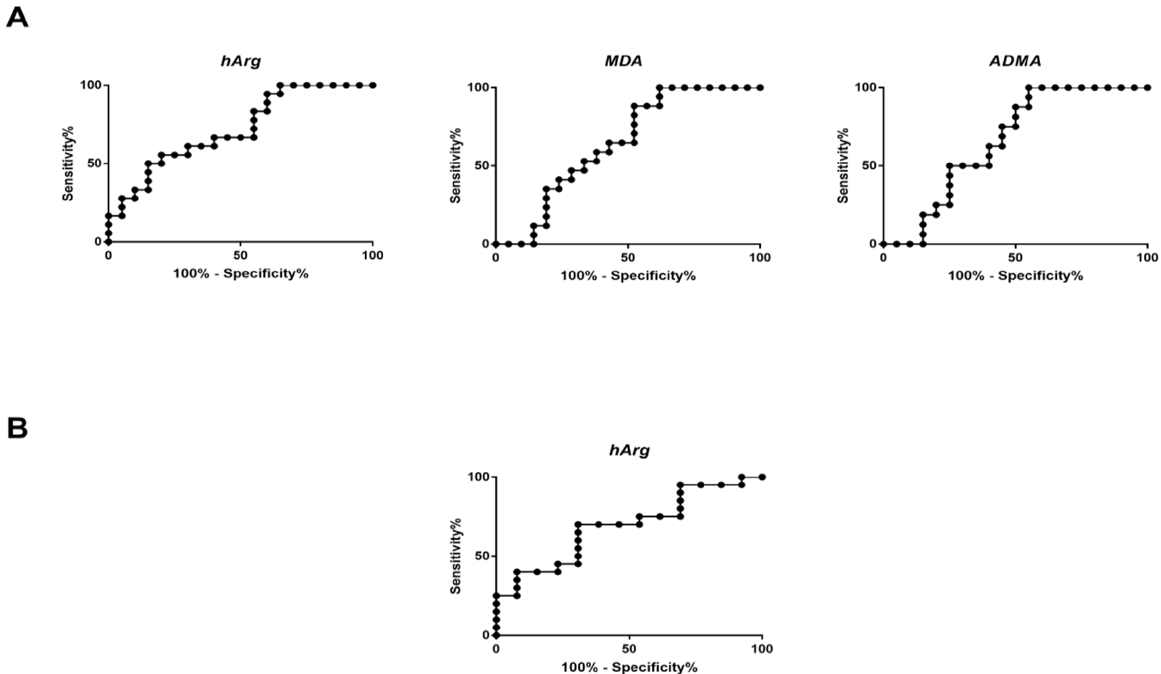
Figure 1 . Box plots of serum concentrations of homoarginine (hArg), asymmetric dimethylarginine (ADMA) and malondialdehyde (MDA) in the three study groups. Data are plotted as median with range. An asterisk indicates statistical significance ( q < 0.05).